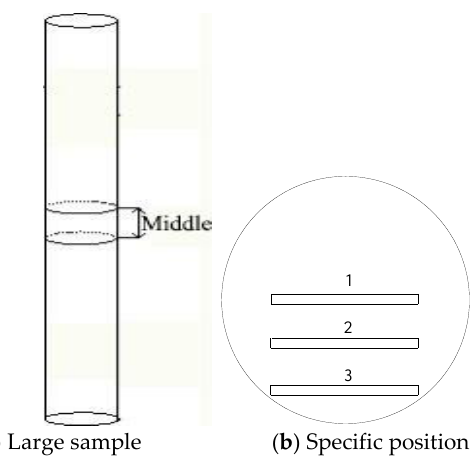
Figure 2. Positions of the H13 steel samples: ( a ) Large sample taken from the middle of the ingot after annealing; ( b ) Individual test samples taken from the center (#1), half-radius (#2), and outer surface (#3) of ( a ) after tempering.